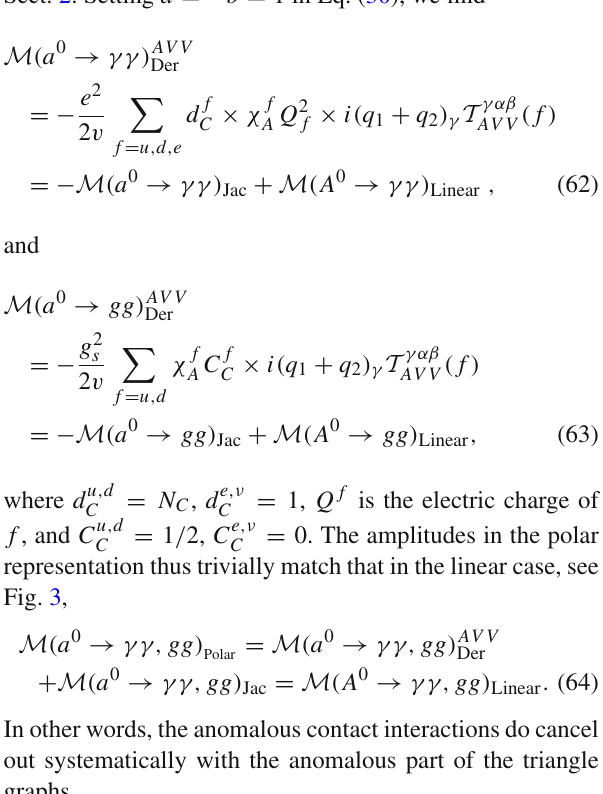
Fig. 4 Contributions to the axion decay into γ Z in the polar (left) and linear (right) representations, using the same notations as in Fig. 3. All the SM fermions but the neutrinos circulate in the